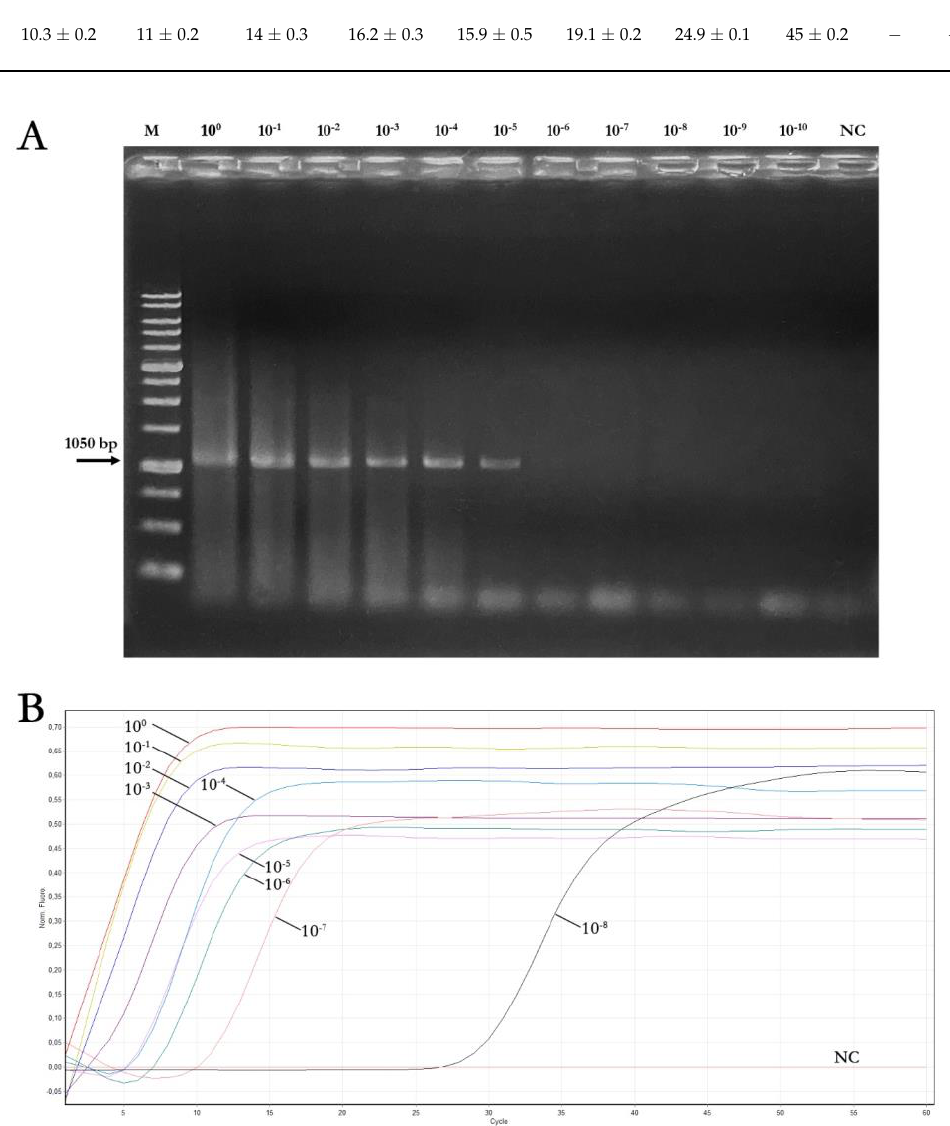
Figure 3. Sensitivity of the end-point PCR and real-time LAMP assays for ToLCNDV detection using 10-fold serial dilution PCR products of three ToLCNDV isolates (Trapani1703 isolate showed in this figure). ( A ) Agarose gel electrophoresis of PCR products. M: Nippon Genetics 1 Kb ladder RTU, NC: negative control. ( B ) Fluorescence of the 10-fold serial dilutions analysed. Fluorescence increased in positive sample curves (from ≈ 50 × 10 -1 ng/ µ L to ≈ 50 × 10 -8 ng/ µ L) after 2 to 30 min.